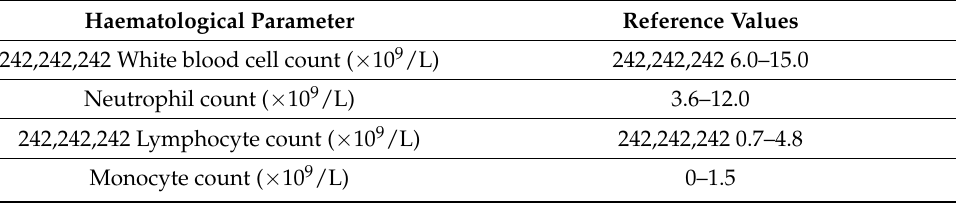
Table 1. Standard canine reference values for haematological